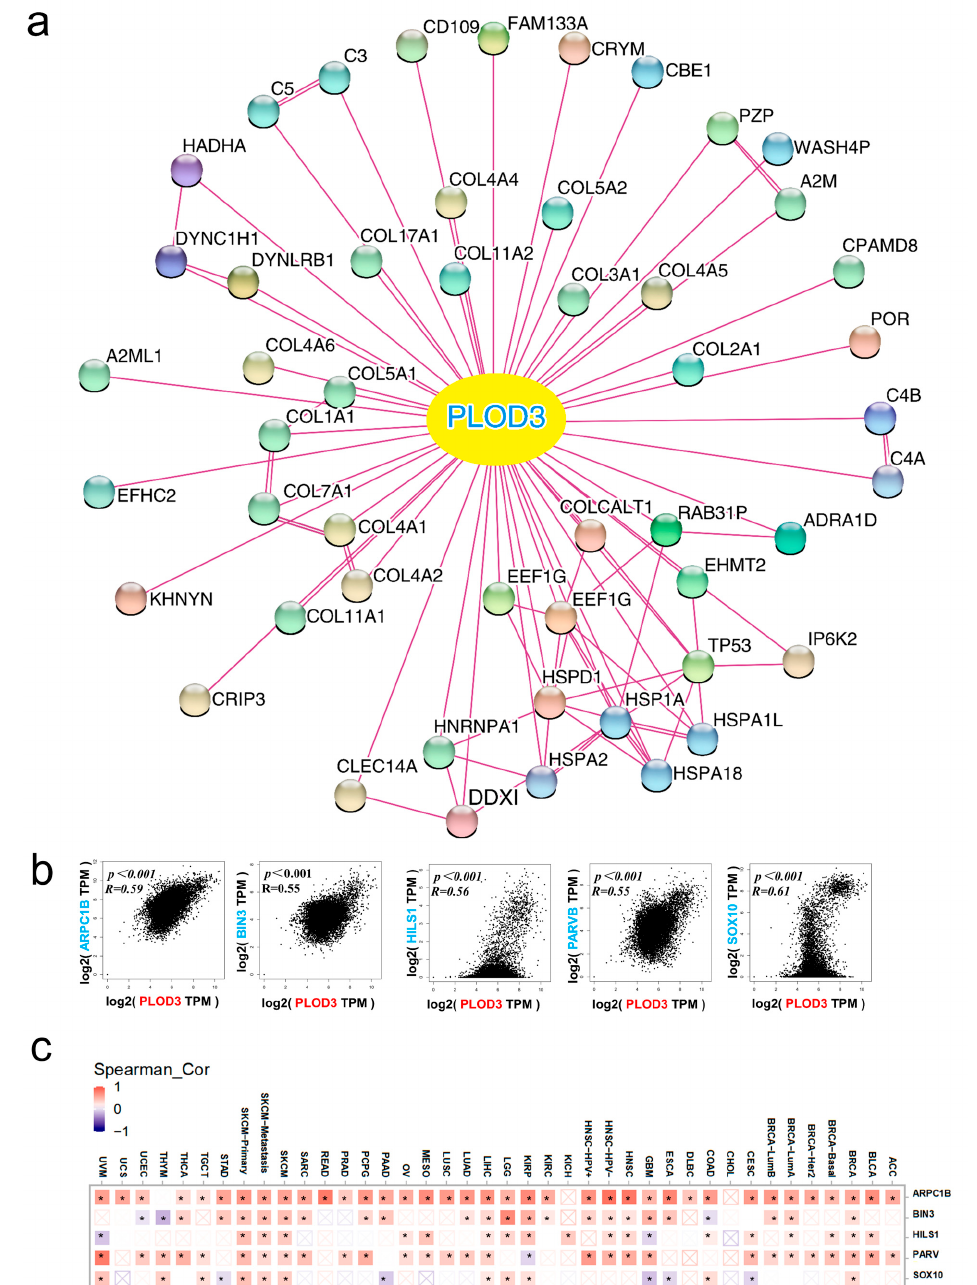
Figure 6. PLOD3 related gene enrichment analysis. ( a ) STRING tool was used to obtain the available, experimentally determined PLOD3-related proteins; ( b ) The GEPIA2 approach was employed to obtain the top 100 PLOD3-correlated genes in TCGA database and the relation between PLOD3 and selected targeting gene expressions were analyzed. The top five genes are shown; ( c ) The corresponding heatmap data in all investigated cancer types are displayed. * p < 0.05. Figure 6c presents the positive relation between PLOD3 expression level, with ARPC1B, HILS1, PARVB and BIN3 in most cancers from TCGA database, and a positive correlation with SOX10 in some of the